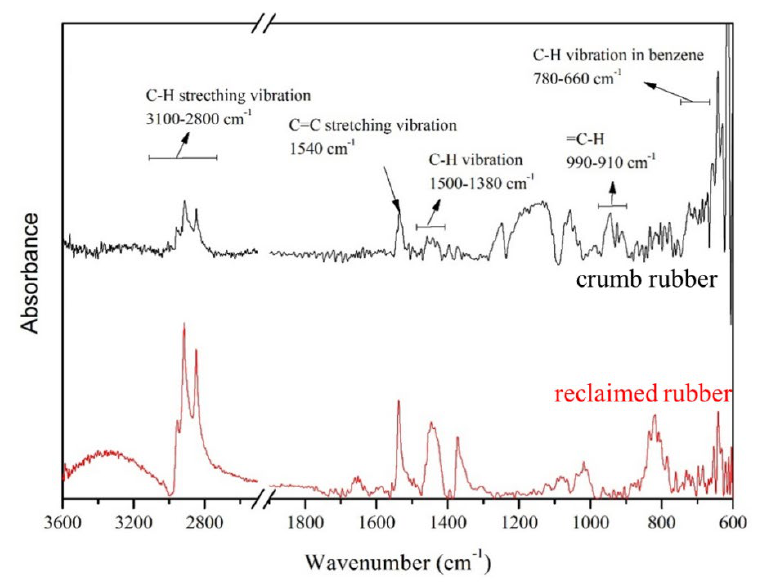
Figure 4. FTIR spectra of rubber samples before and after devulcanization. Table 1. Property of rubber samples before and after devulcanization.